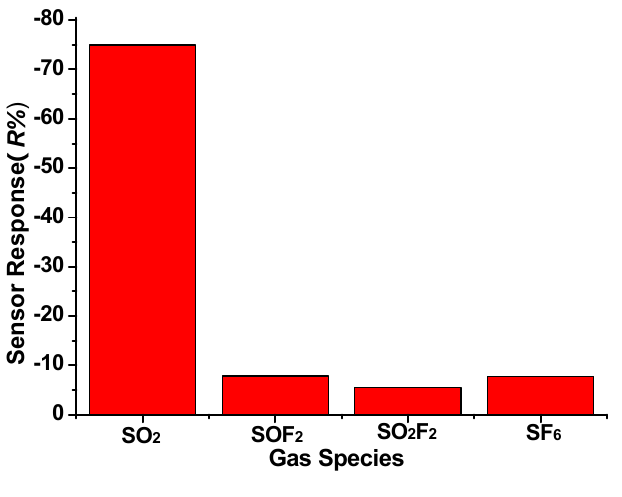
decomposition 6